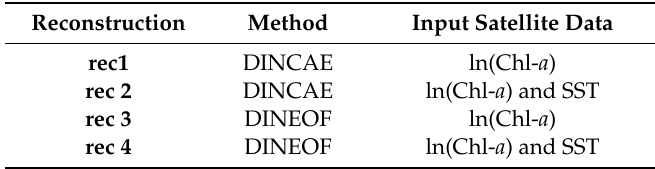
Table 1. Four reconstruction schemes.